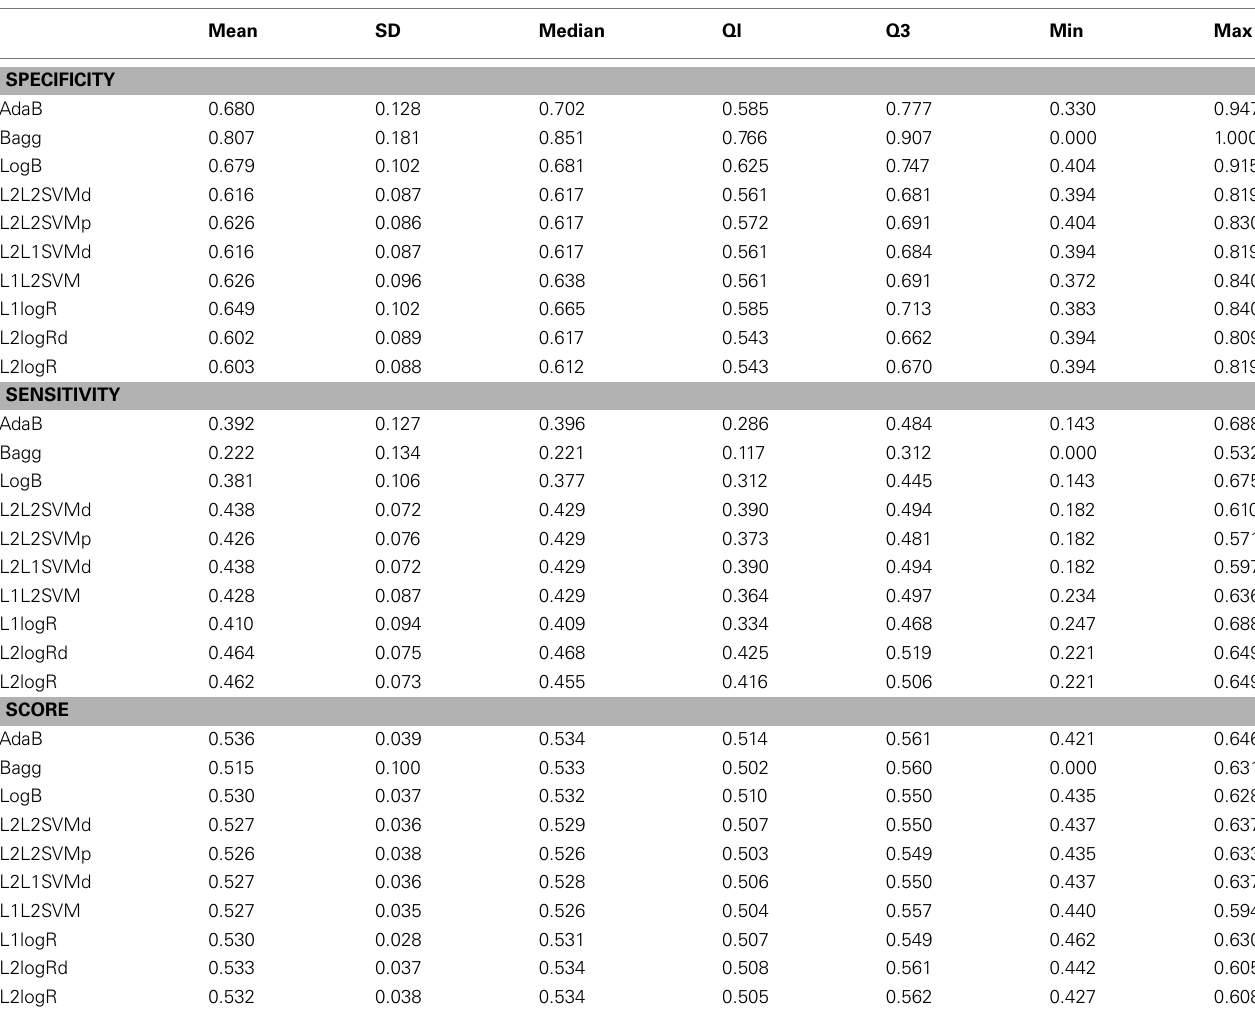
TableA1 | Descriptive statistics of the performance measures inTD control vs.ADHD patients classification when using fALFF + REHO